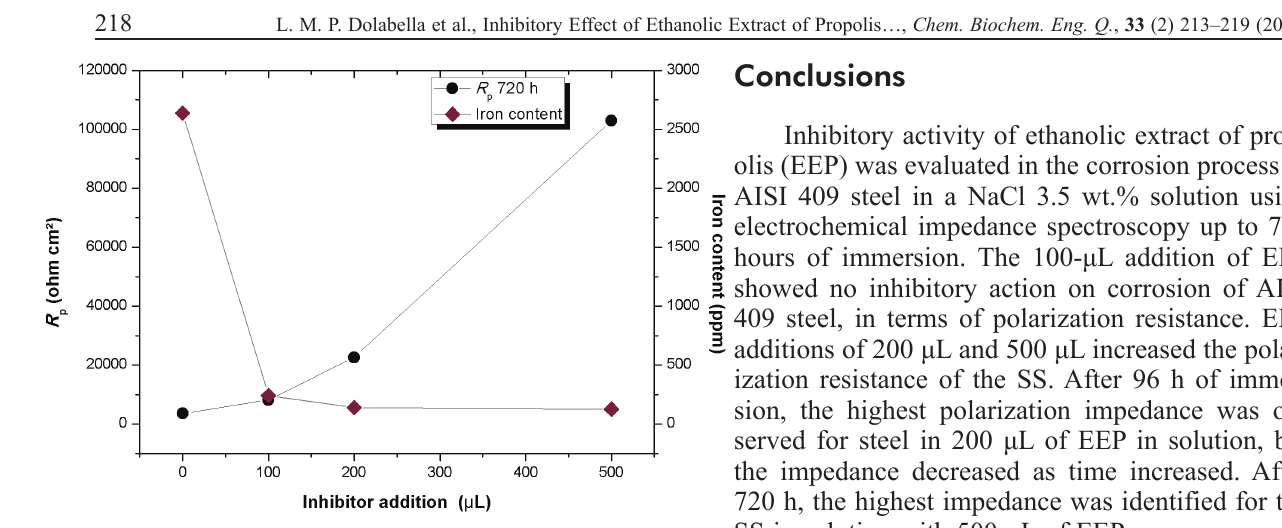
Fig. 6 – Iron content in corrosion product and polarization resistance after 720 hours of